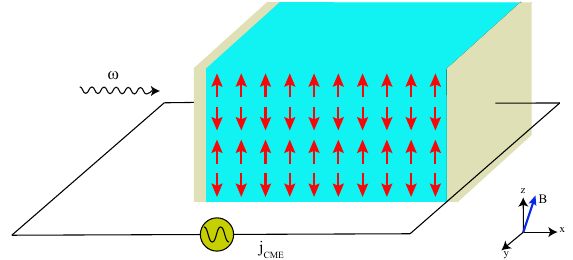
Fig. 4 Experimental setup for detecting the tunable dynamical ME effect. A tilted static magnetic is applied with components along both x and z directions. A microwave magnetic fi eld with a frequency of ω is applied along the in-plane x -direction to drive the AFM resonance. The chiral magnetic effect due to the time- varying dynamical ME coef fi cient will lead to a measurable inplane response